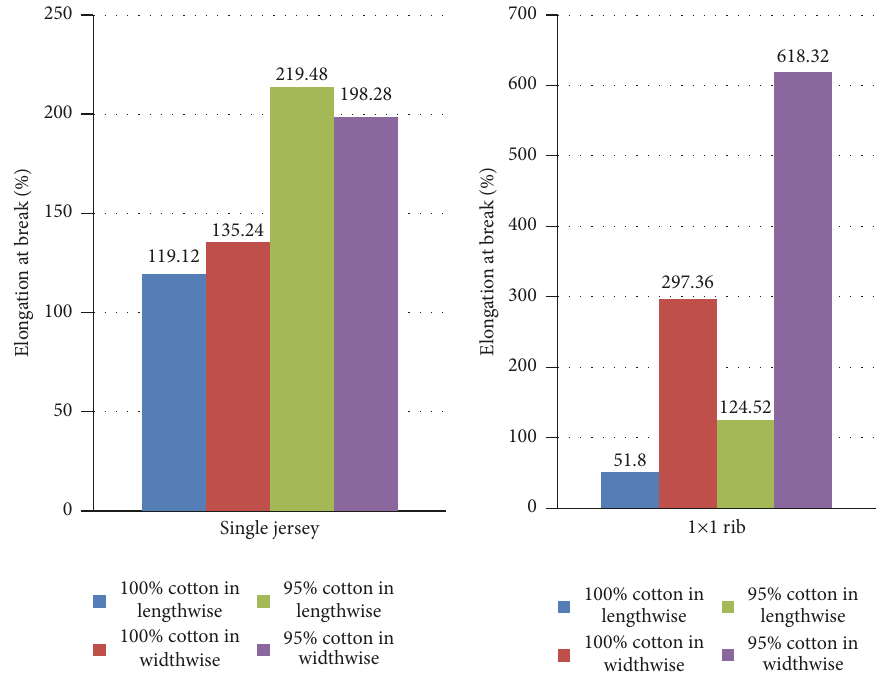
Figure 2: Elongation percent of single jersey and 1 × 1 rib knitted